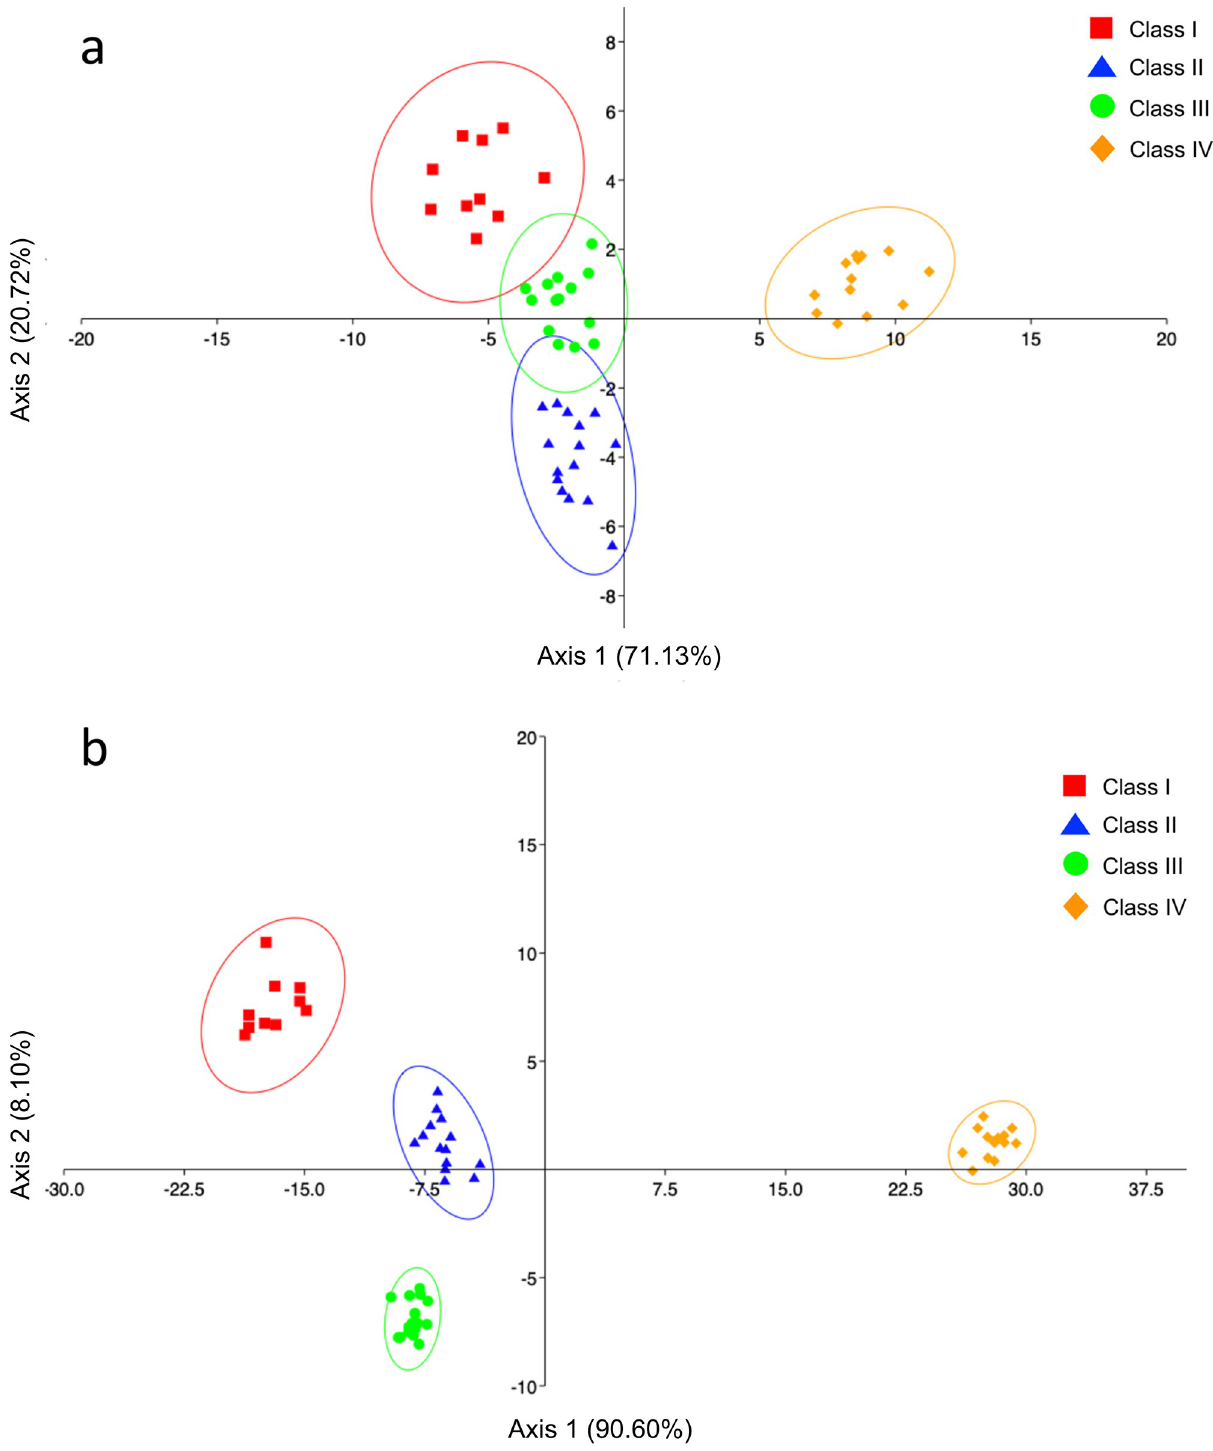
Fig 5. Linear Discriminant Analysis (LDA) computed between the size classes analyzed, calculated on Wavelet Fourier descriptors obtained by the left side (a) and right (b) of sagittae . Ellipses includes 95% confidence interval.